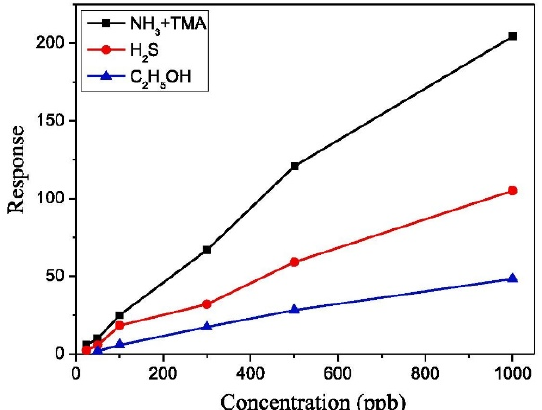
Figure 8. Response curve of Au patch electrode Ag-SnO 2 /SiO 2 /Si metal-insulator-semiconductor capacitive gas sensor for increasing concentrations of ammonia and trimethylamine (NH 3 + TMA), hydrogen sulfide (H 2 S) and ethanol, Reprinted with permission from ref. [155]. Copyright 2020 Else- vier.